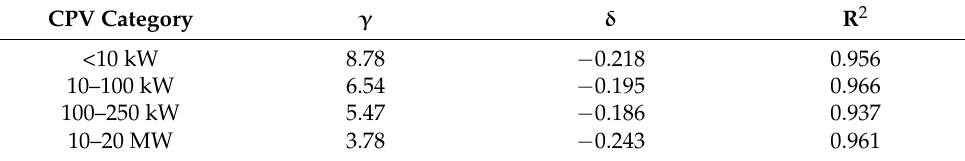
Figure 9. Unit costs of the electric power supplied by a CPV system in terms of the CPV system power capacity for the four categories. Table 5. Coefficients values of the equation describing the trends of the unit cost of the electric power supplied by a CPV system as a function of the CPV power capacity for the four categories defined.